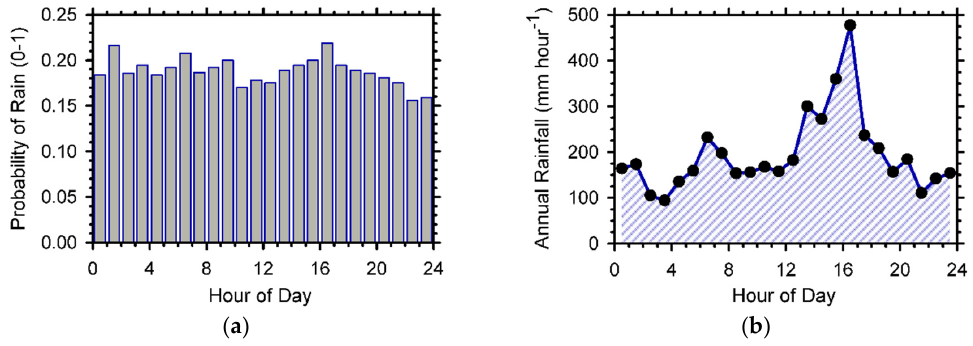
Figure 6. ( a ) The likelihood that rain will occur within any given hour at La Selva is quite uniform